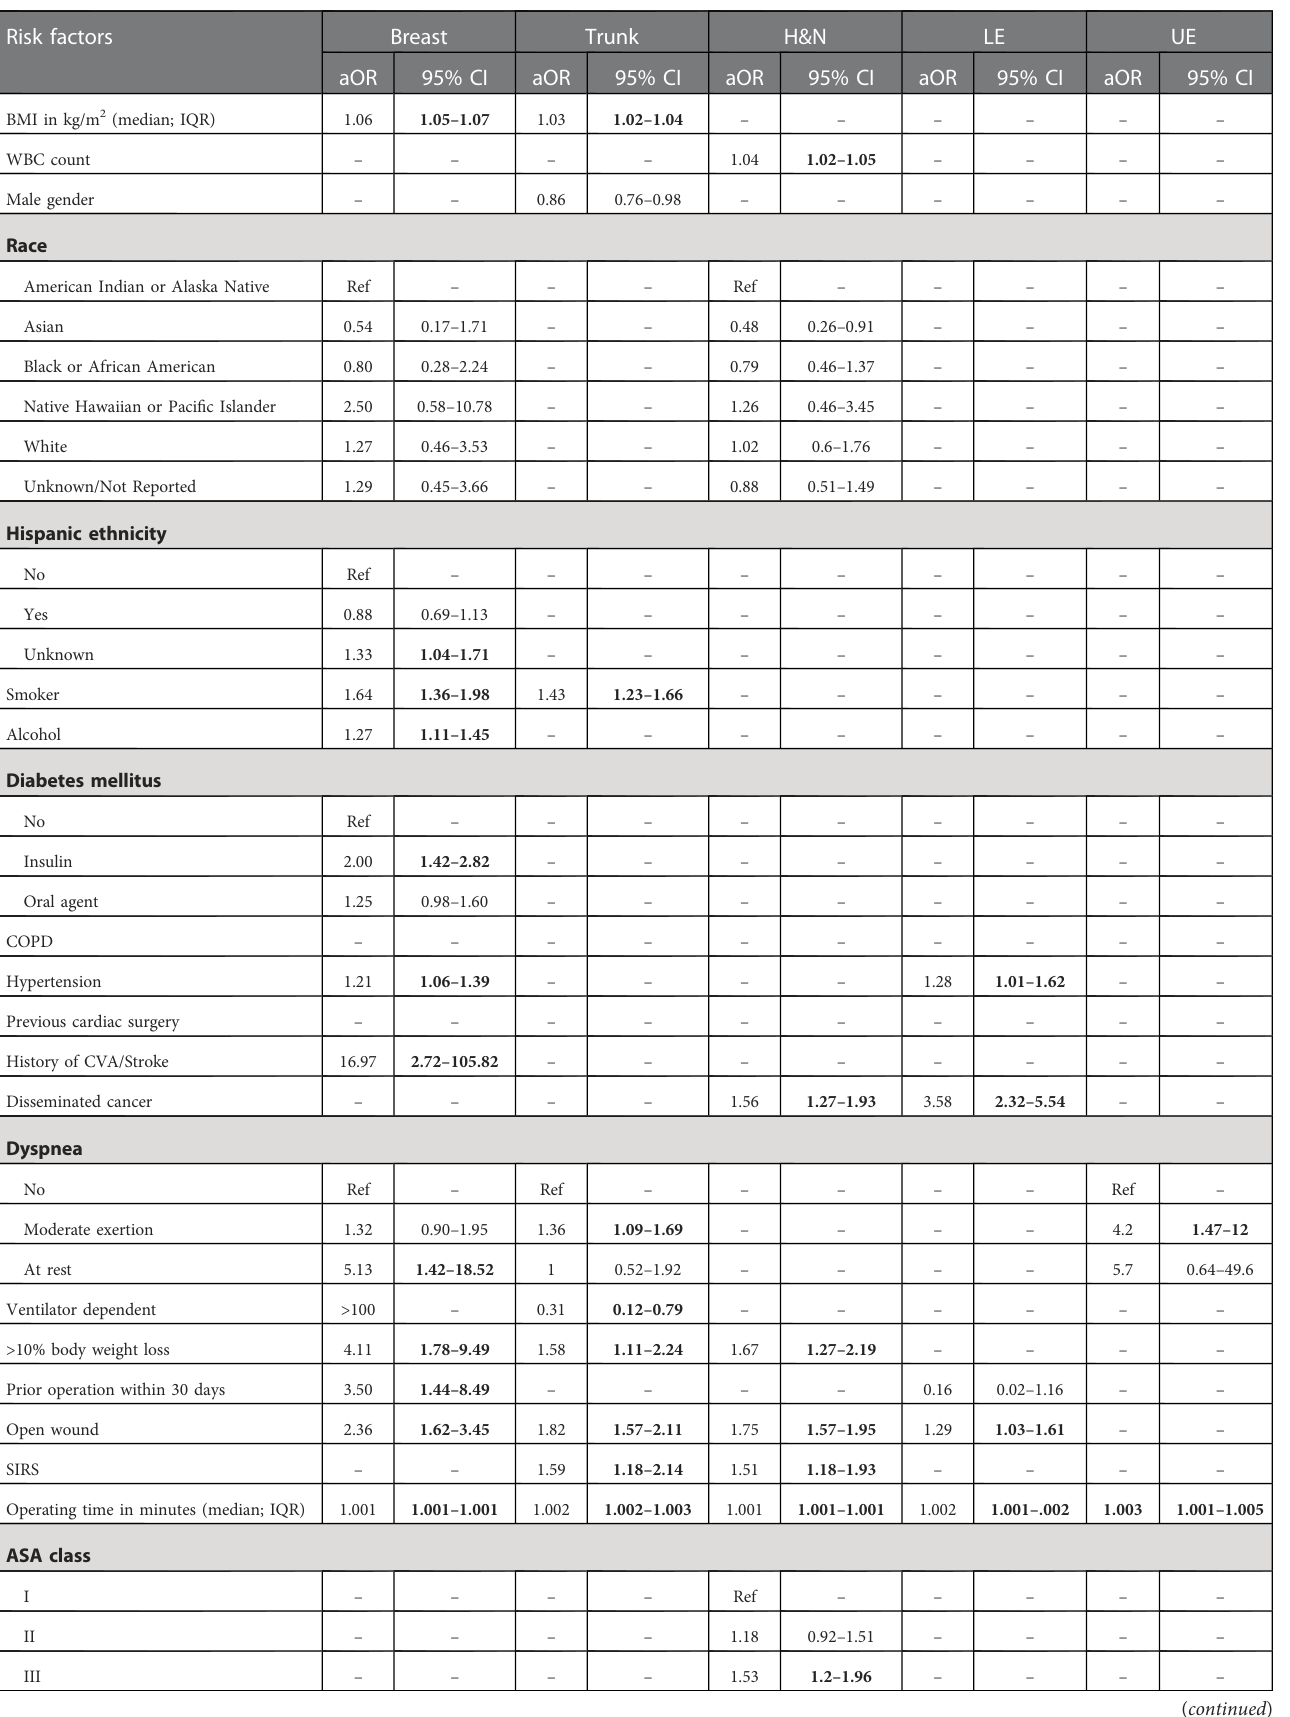
TABLE 2 Multivariate regression evaluating predictors of SSI following fl ap reconstruction strati fi ed by fl ap reconstruction